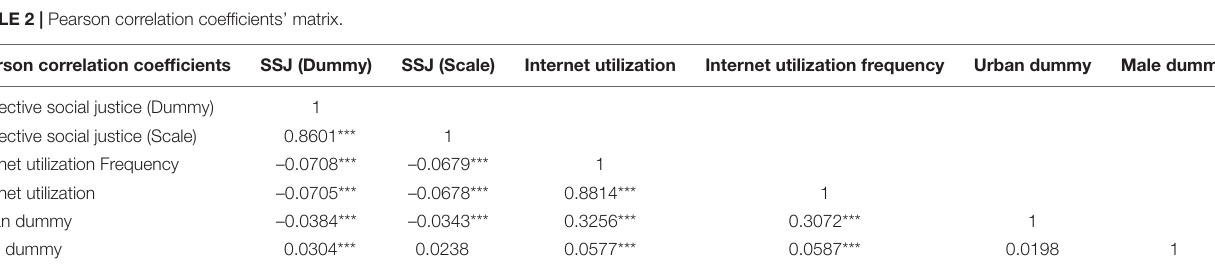
FIGURE 1 | The negative association between Internet use and subjective social justice. The graph is computed based on authors’ calculation. TABLE 2 | Pearson correlation coefficients’